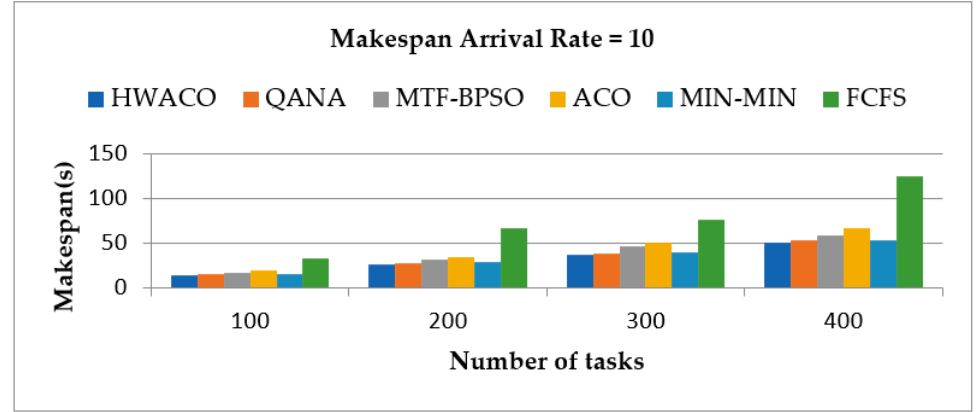
Figure 2. Execution time for the tasks with onset rate of 10.